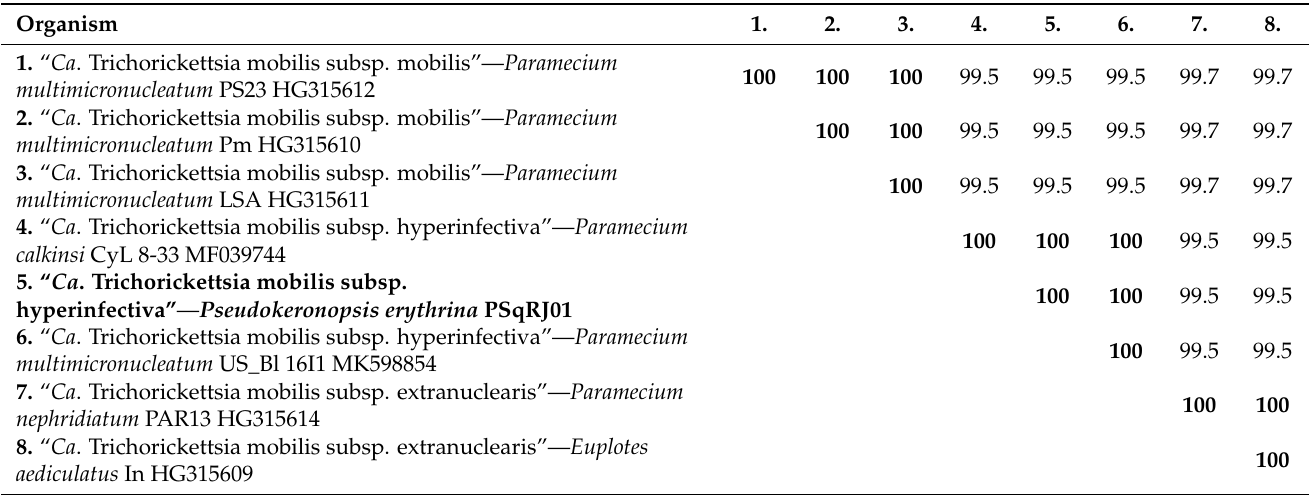
Table 2. Percent identity values of the 16S rRNA genes of “ Ca . Trichorickettsia” on the “no insert” matrix (i.e., excluding the typical insert present in these bacterial endosymbionts: 1095 nucleotide positions). The newly characterized sequence of the endosymbiont of Pseudokeronopsis cfr. erythrina PSqRJ01 is highlighted in bold. Full identity values are highlighted in